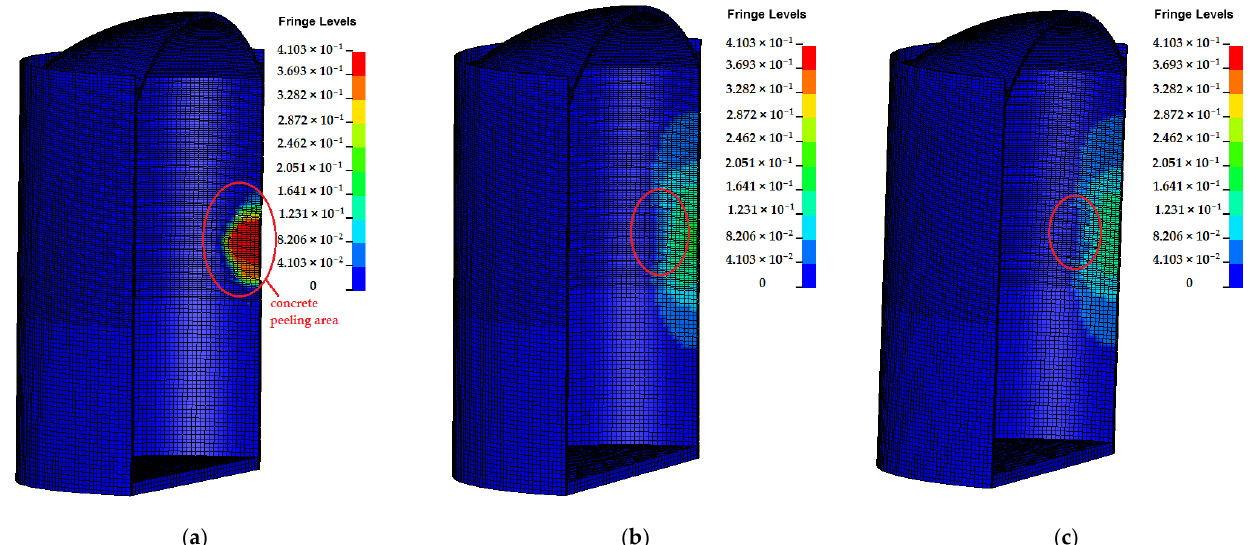
Figure 10. Contours of the maximum impact displacement and concrete peeling off area of full SC containment. ( a ) C50; ( b ) C55; ( c ) C60.